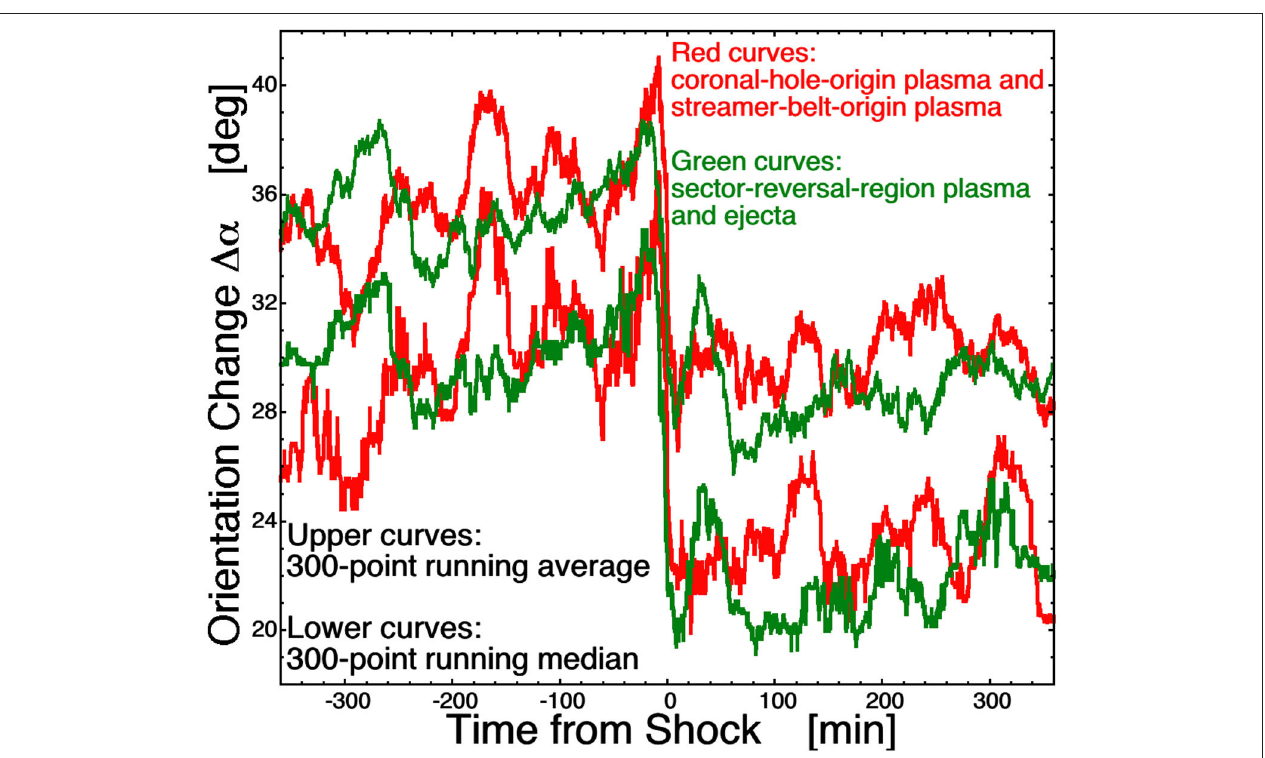
FIGURE 6 | 300-point running averages (upper curves) and 300-point running medians (lower curves) are plotted for 57 shocks that are propagating through coronal-hole-origin plasma or streamer-belt-origin plasma (red curves) and for 47 shocks that are propagating through sector-reversal-region plasma or ejecta (green